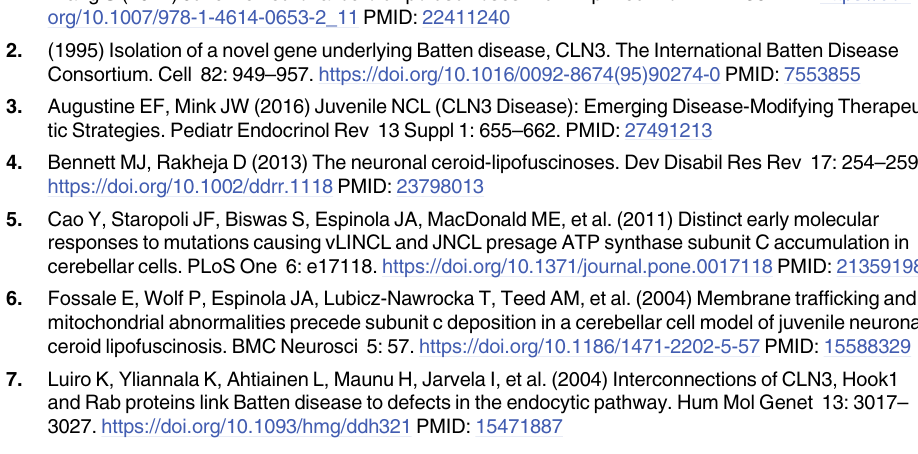
S4 Table. Differentially expressed genes (up- and down-regulated genes) in GalCer- versus